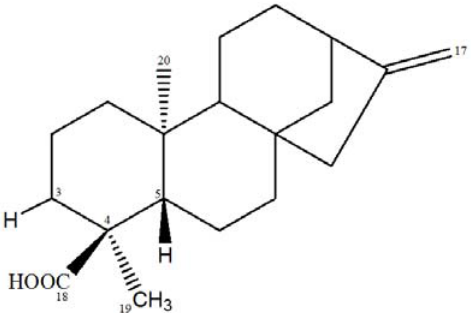
Figure 1. ent -kaur-16-en-18-oic